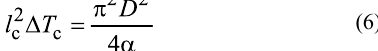
If the rise in temperature has an upper bound, Δ T c , the critical stress in Equation 4 can be considered as the maximum thermal stress on a doubly clamped